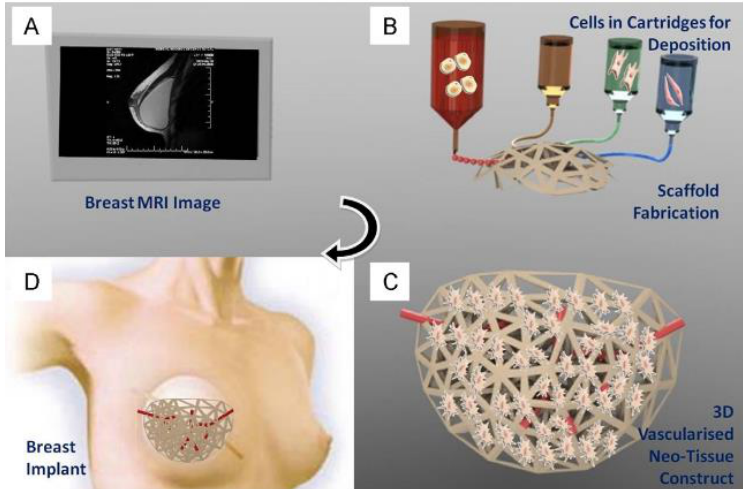
Figure 2. Application of patient’s MRI data to generate a bioprinted scaffold for organ regeneration, disease treatment, or drug delivery. MR images ( A ) of the target organ/tissue will be acquired and